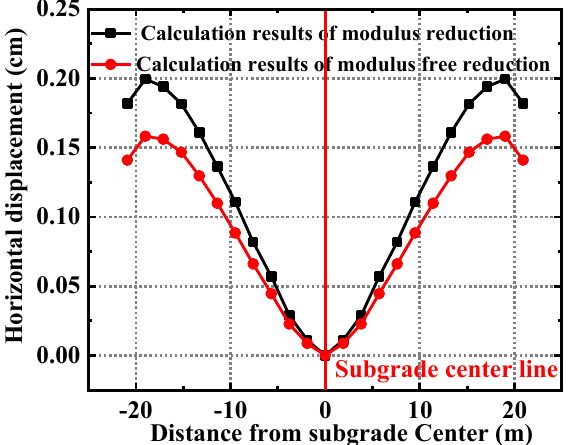
Figure 21. Horizontal deformation distribution on the top surface of